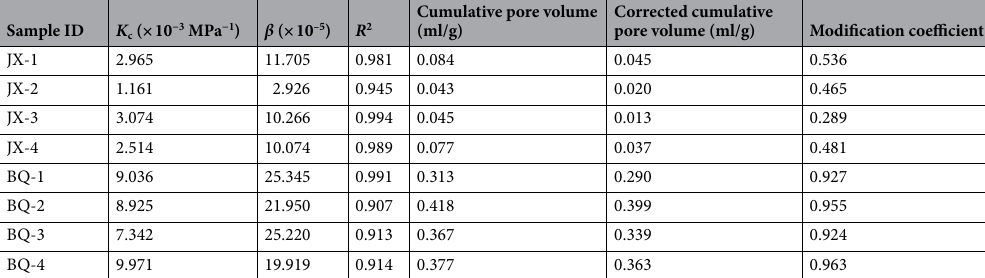
Table 3. Compressibility correction parameters.